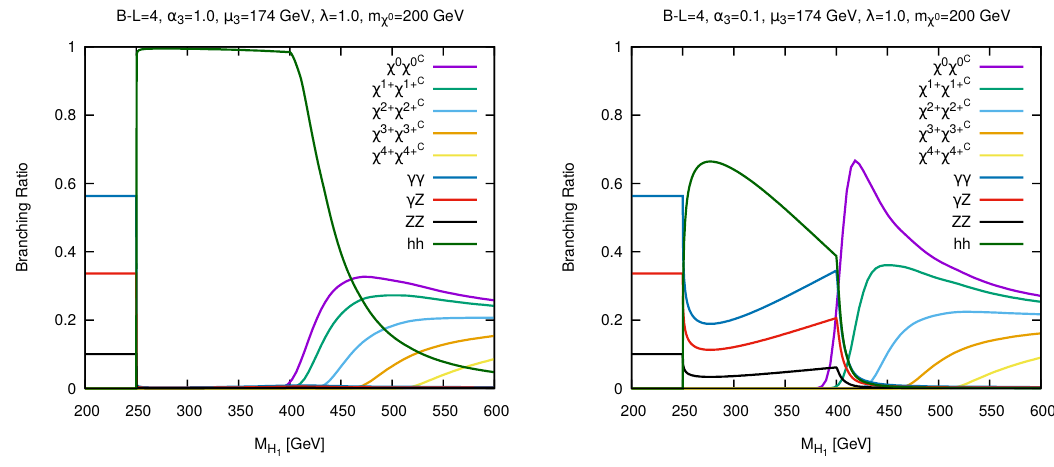
Figure 6 . The decay branching ratios of singlet scalar ( H 1 ) as a function of its mass. The left (right) panel is for (cid:11) 3 (cid:22) 3 = v EW (0 : 1 v EW ). In both the panels we consider B (cid:0) L = 4 case with (cid:21) = 1 : 0 and m = 200 (cid:31) 0